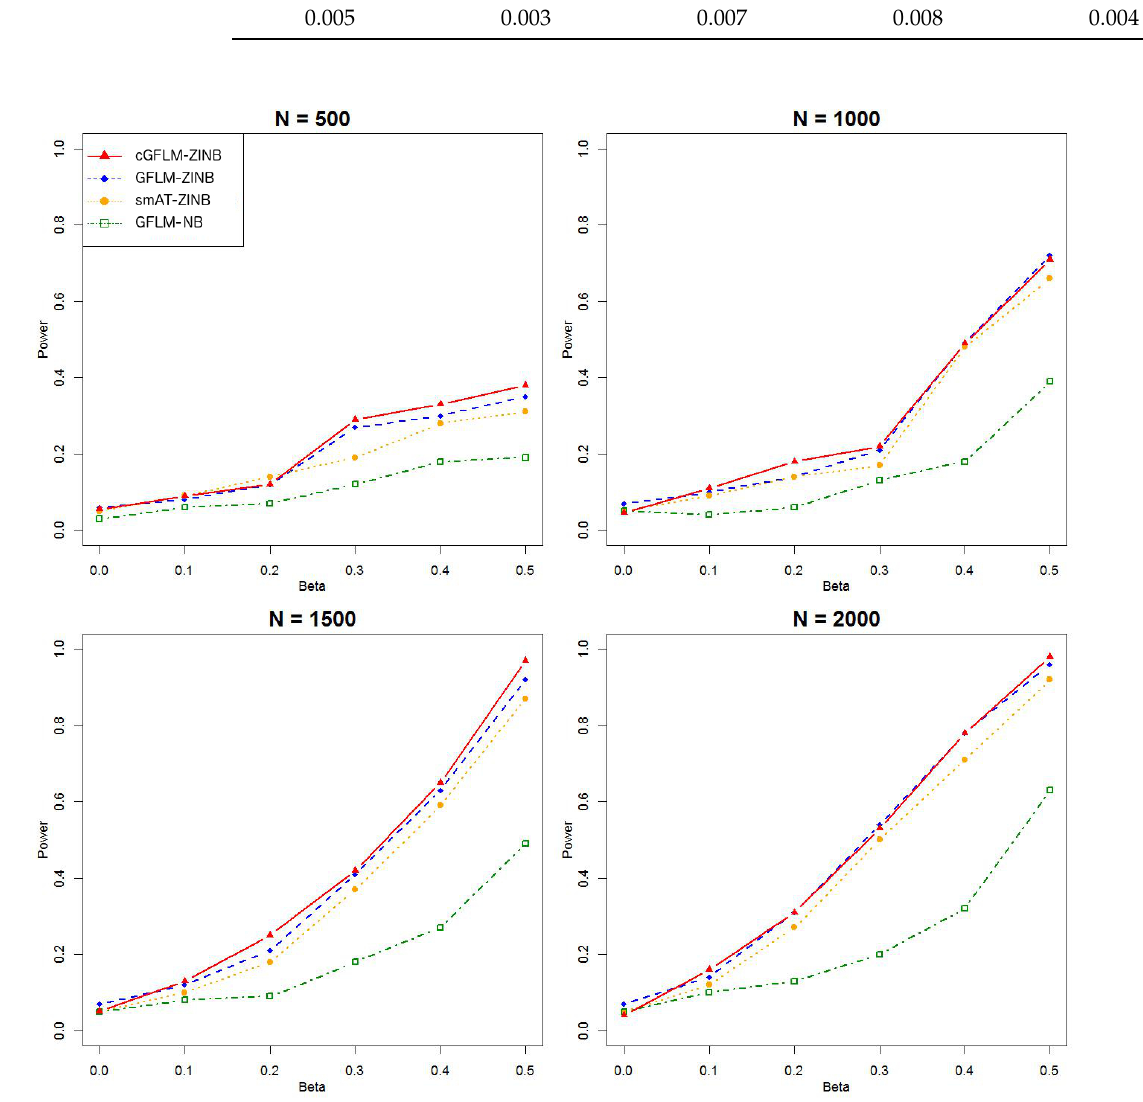
Figure 4. Power simulation for ZINB outcomes based on random LD blocks, single causal locus, effect in latent Bernoulli